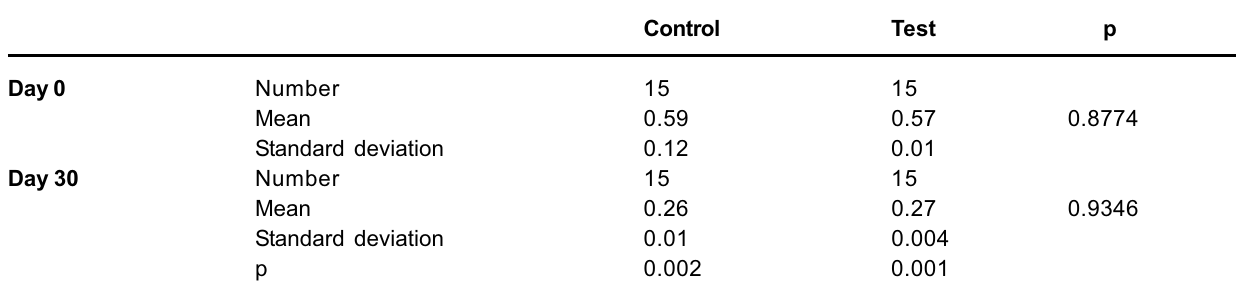
TABLE 2- Gingival Bleeding Index (GBI) means and standard deviation on day 0 and day 30 for the control and test groups Control